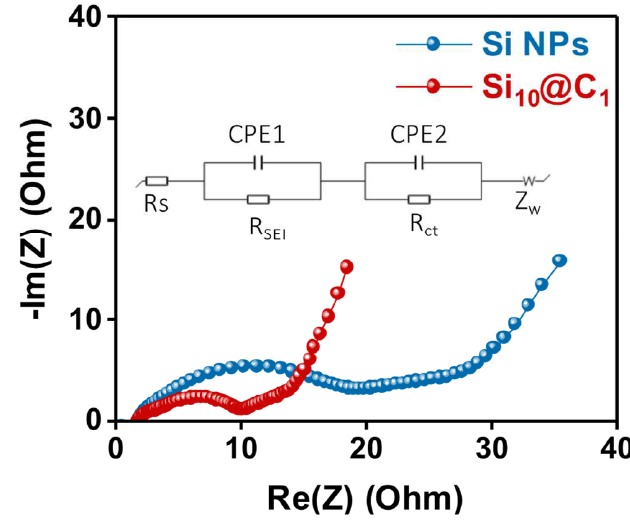
Figure 6. Nyquist plot of the Si- and Si 10 @C 1 -based electrodes.